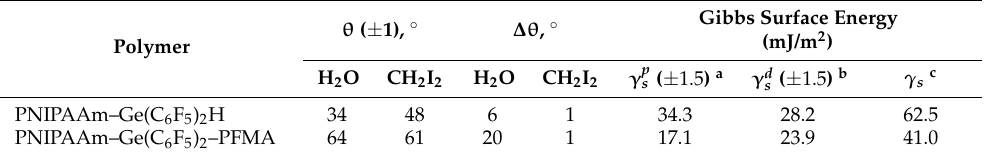
Table 4. The equilibrium contact angle ( θ ) and energy characteristics of LB films of functional